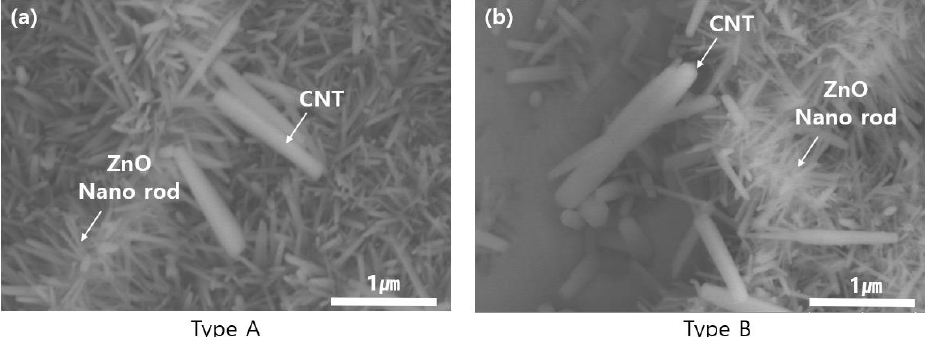
Figure 5. FE-SEM image of samples ( a ) type A ( b ) type B.